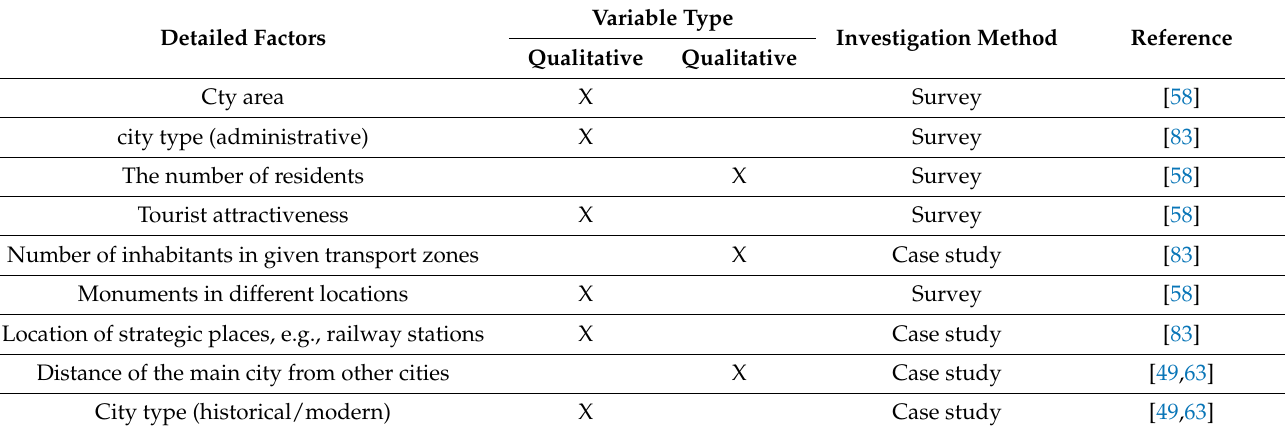
Table 16. Factors related to the demographic and social structure of the